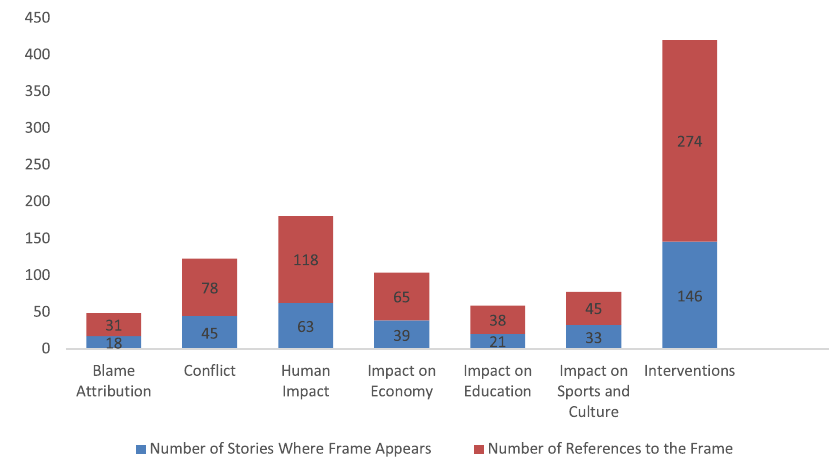
Fig. 3 Times of Eswatini issue/frame salience. The chart shows the salience given to different issues in the Times of Eswatini. It shows that newspapers paid much attention to government interventions, the impact of the virus on sports and culture, the human impacts of the virus, and the impact of the virus on education and lastly the impact of the virus on the